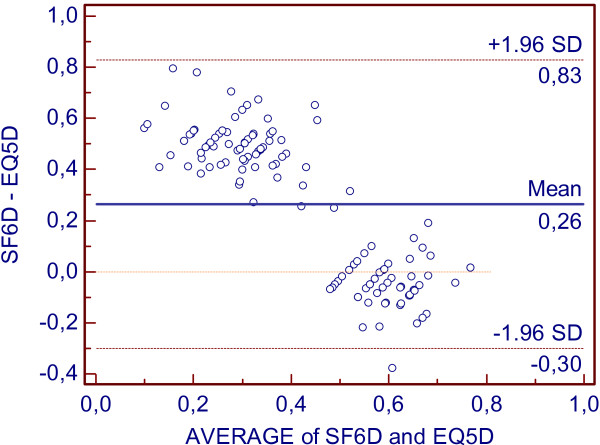
Bland-Altman plot.